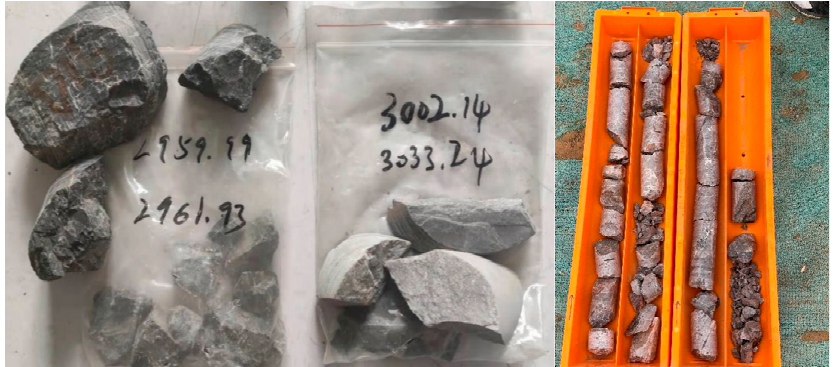
Figure 2. Core samples of the Gaoyuzhuang Formation from wells D22 and D16 in the Xiongan New Area.